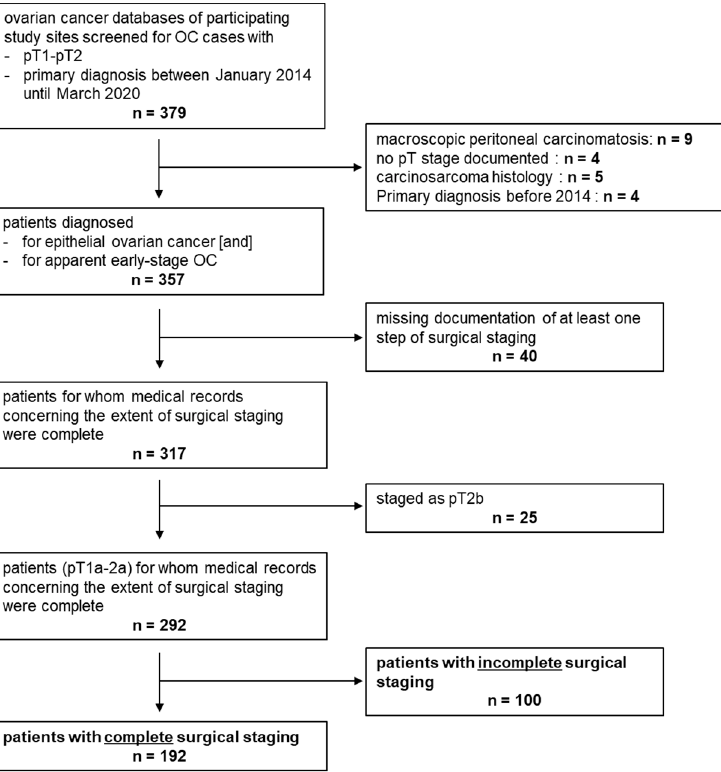
Figure 1. Consort Diagram. Data sets from 379 ovarian cancer patients with pT1-2 stage were collected. Since 22 cases finally did not fulfil inclusion criteria or had macroscopically visible peritoneal carcinomatosis outside the pelvis, they had to be excluded (Figure 1). In total, 357 patients with apparent early-stage OC were analysed. For analysing details on surgery, those patients with full medical records on surgical staging ( n = 317) and—as long as not stated otherwise—apparent pT stage pT1-pT2a ( n = 292) were selected (Figure 1).